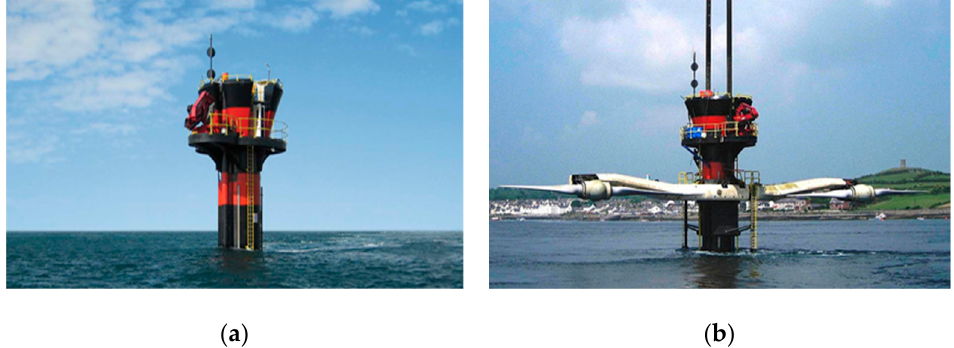
Figure 1. SeaGen-Device, ( a ) submerging state; ( b ) lifting state.